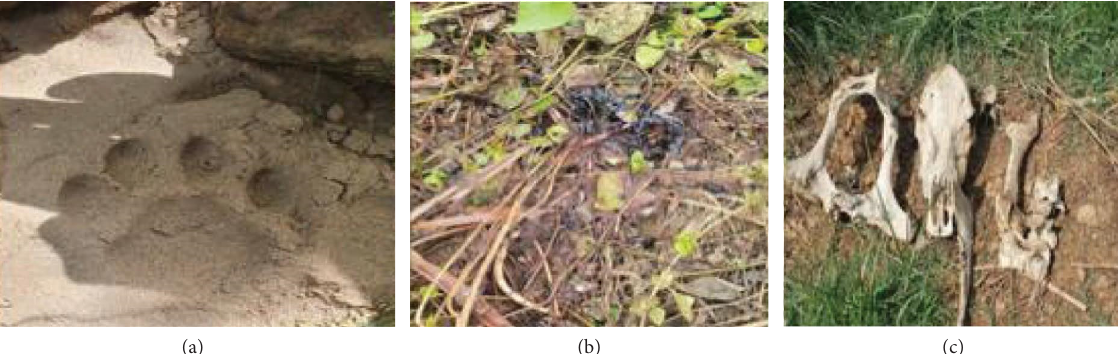
Figure 8: (a) Hoof marks, (b) animal blood, and (c) animal remnants in the Bijnor region of Hastinapur wildlife sanctuary, as witnessed by the survey team.